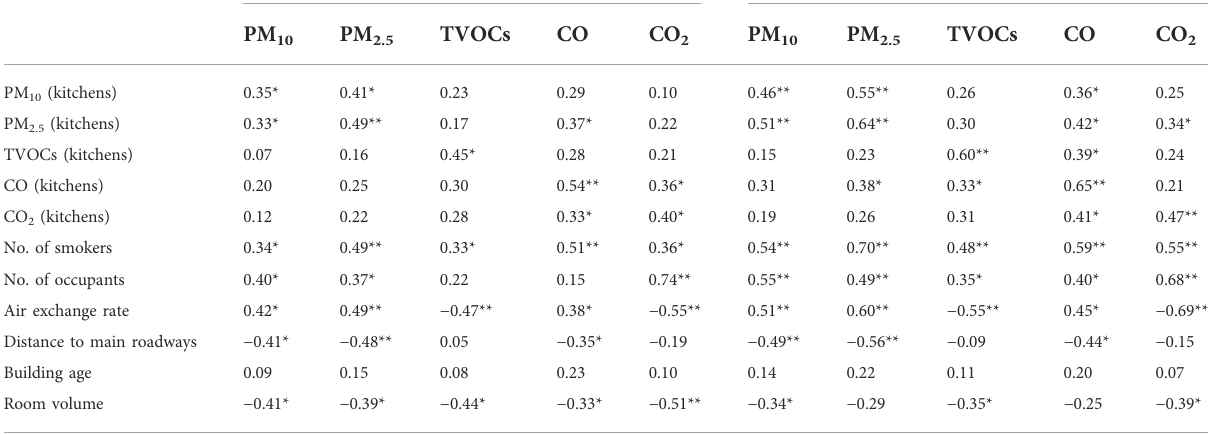
TABLE 5 Correlations between indoor pollutants ’ levels in bedrooms and living rooms and possible determinant factors.